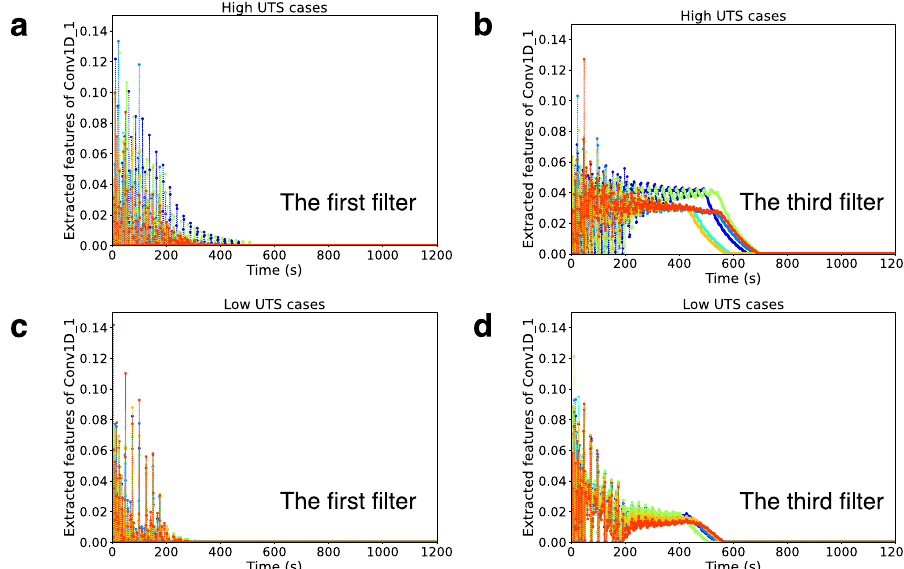
Fig. 10 Comparison of extracted features of the fi rst convolutional layer (Conv1D_1) for high and low UTS cases. a , c Extracted features of Conv1D_1 with the fi rst feature fi lter for high and low UTS cases. b , d Extracted features of Conv1D_1 with the third feature fi lter for high and low UTS